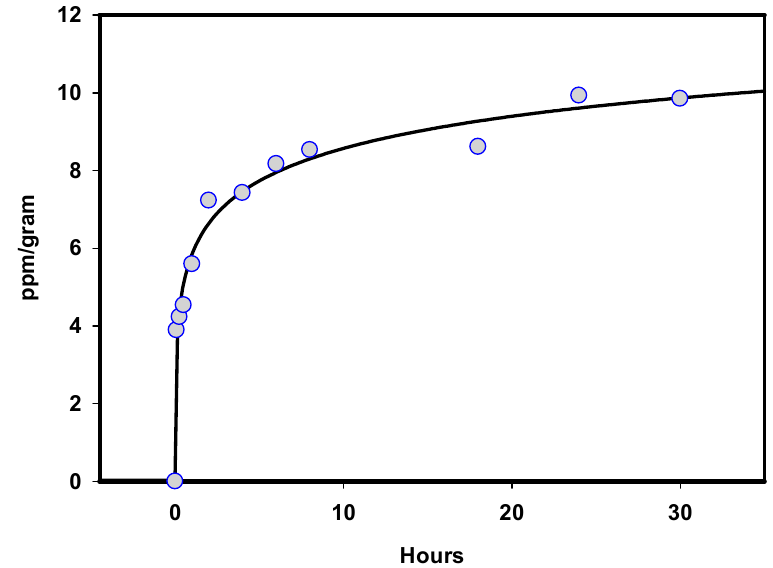
Figure 2. Copper ions elution from Copper oxide-containing wound dressings (COD) . One-gram swatches of COD were incubated with saline at 37 °C between 5 min to 30 h. The amount of cop- per ions eluting to the saline solution was determined by colorimetry assay using bicinchoninic acid [38].